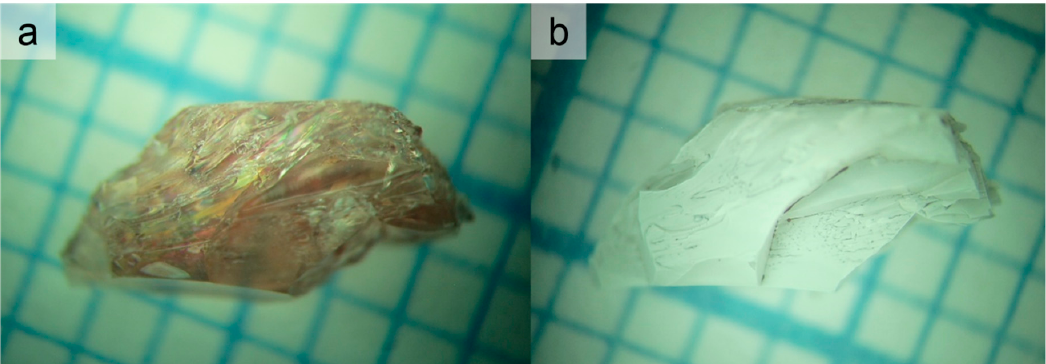
Figure 5. Sample of alkali ‐ aluminophosphate glass Na ‐ Al ‐ P_238 doped with 0.15 wt.% 238 Pu (9.5 × 10 3 Bq of 238 Pu per gram of glass): pristine sample before leaching ( a ) and glass sample after 4.5 months in contact with distilled water at a temperature of 90 °C ( b ).